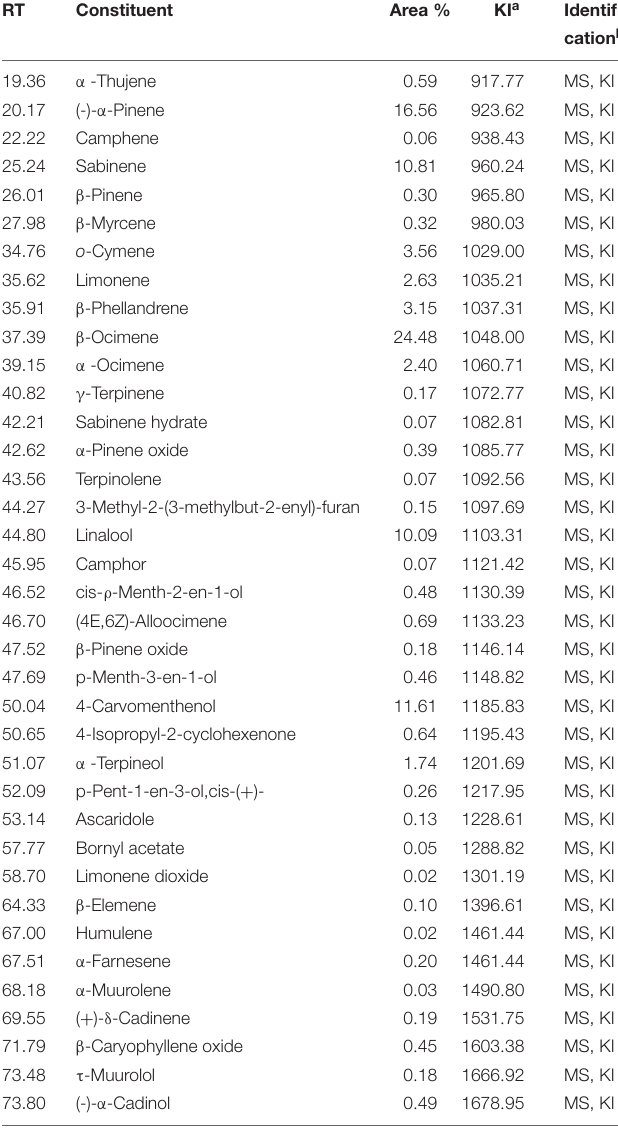
TABLE 1 | Chemical compositions of ZCO